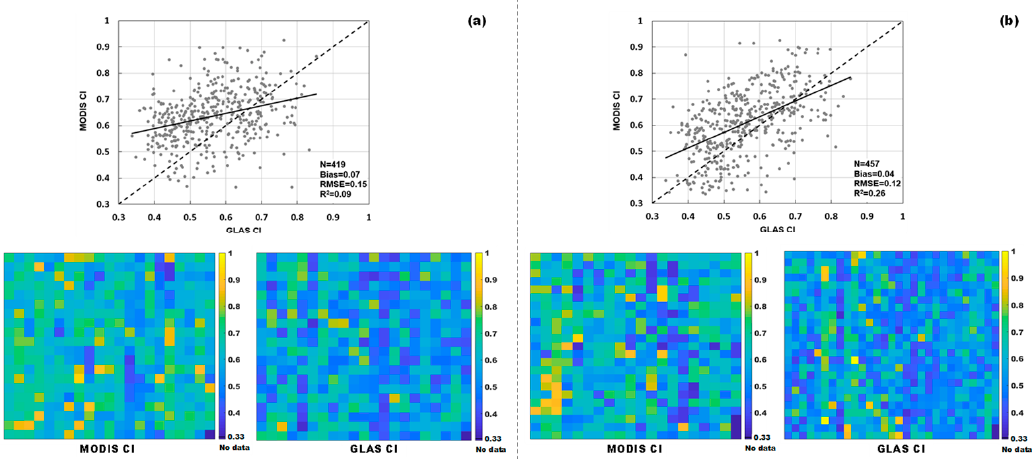
Figure 12. Scattering plots of the comparison between GLAS CI and MODIS CI and the corresponding CI distribution pattern, which are the results after removing the uncertainty comparison data caused by scale effect. ( a ) is the comparison between GLAS CI and V005-MODIS-CI; ( b ) is the comparison between GLAS CI and V006-MODIS-CI.